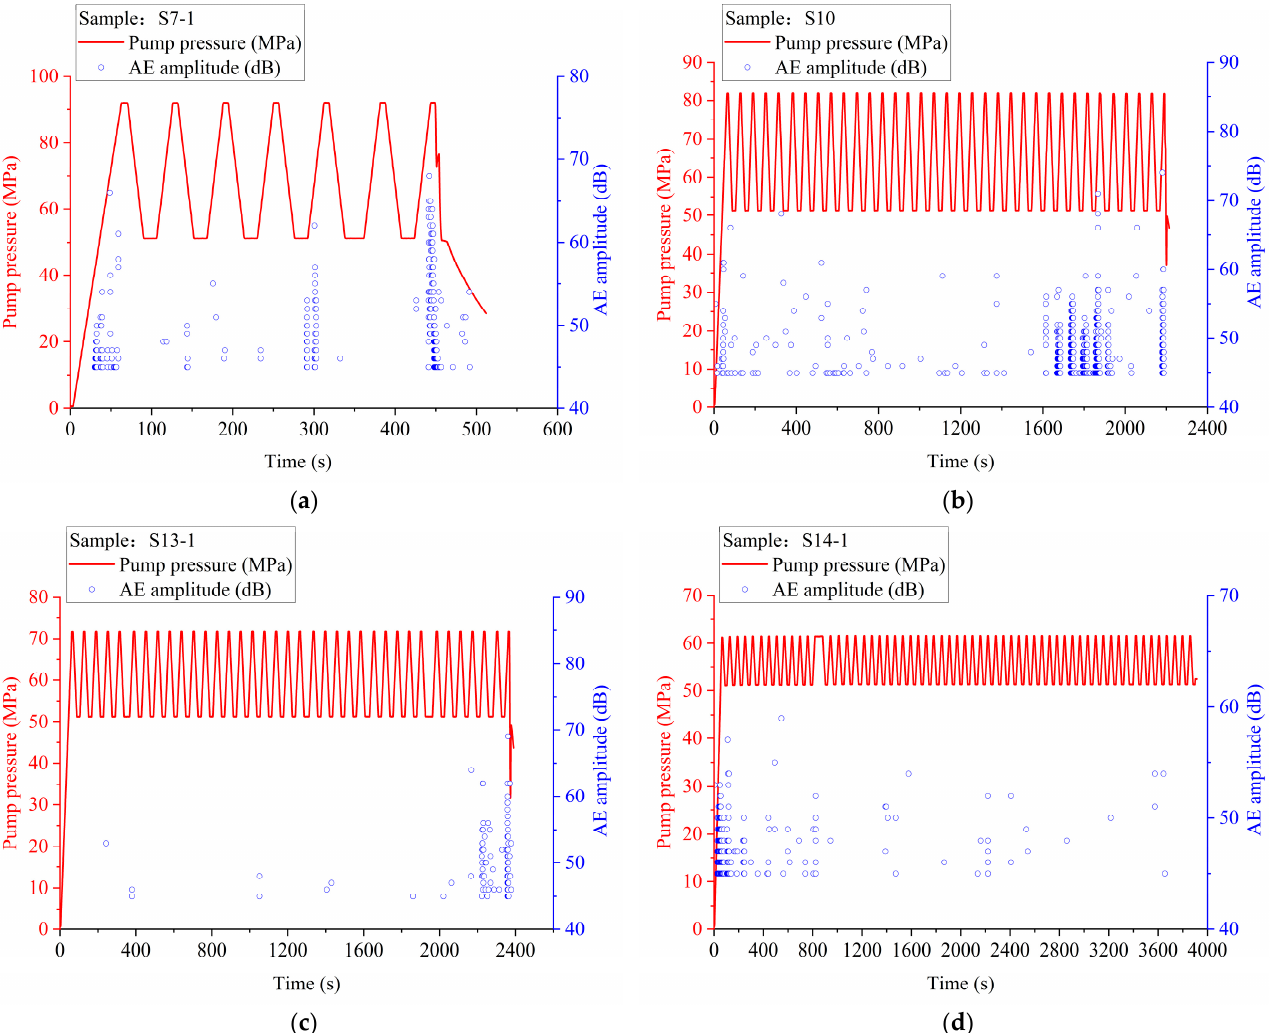
Figure 10. The relationship between pump pressure, AE amplitude, and injection time of samples: